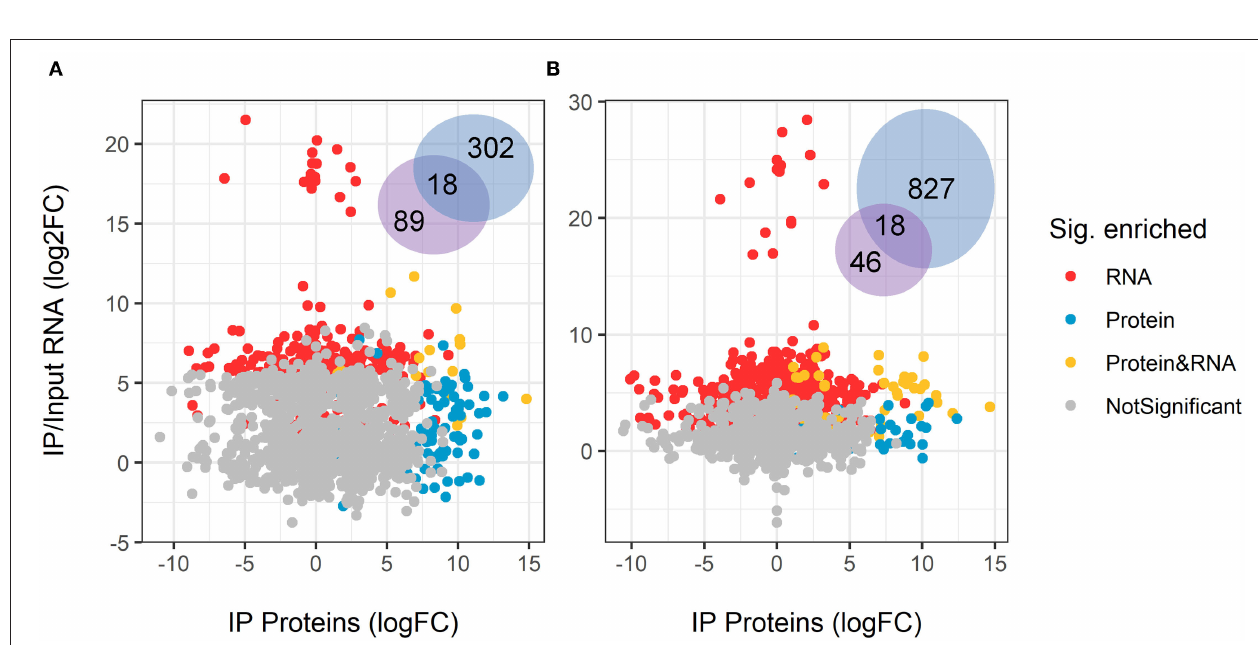
FIGURE 3 | (III) enrichment in both GUL-1 and GUL-1 no nitrogen growth conditions, (IV) enrichment unique to GUL-1 with no nitrogen, (V) shared enrichment between GUL-1 no nitrogen and GUL-1 + Nikkomycin Z growth conditions, (VI) unique enrichment for GUL-1 + Nikkomycin Z, and (VIII) shared enrichment between GUL-1 and GUL-1 + Nikkomycin Z growth conditions. Non-significant observations ( P > 0.05) were adjusted to 0, to emphasize enriched values. STRING-predicted protein-protein association is presented for enriched proteins of (C) GUL-1, (D) GUL-1 with no nitrogen, and (E) GUL-1 + Nikkomycin Z. Nodes represent enriched proteins, while edges mark predicted associations. Only connected nodes are displayed. The networks were all clustered by GLay community structure algorithms for network clustering. Colored nodes indicate STRING KEGG pathway enrichment. Labeled pathways are at the highest available clustering level (i.e., “Metabolic